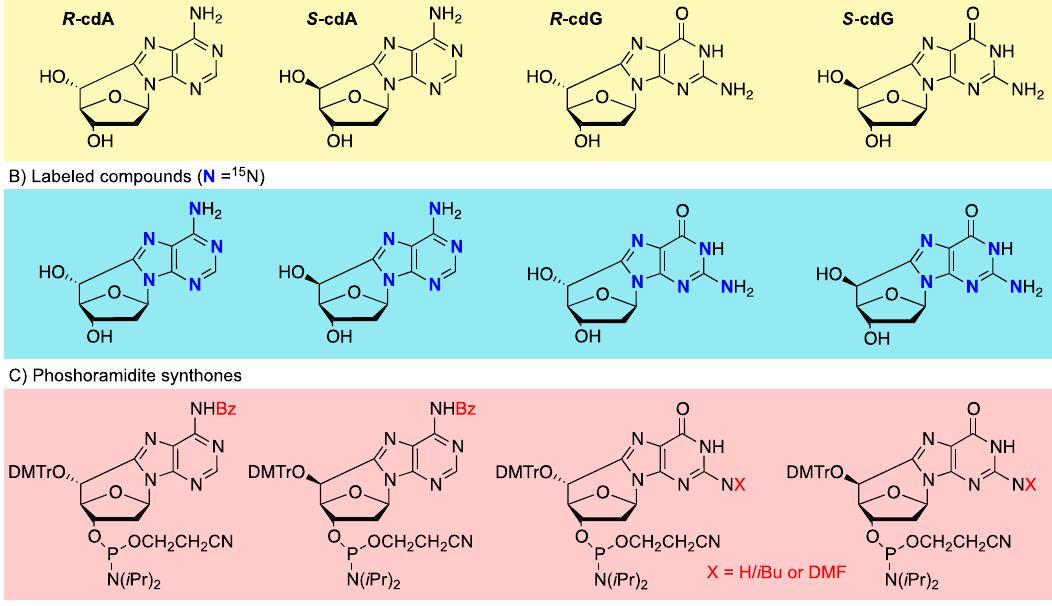
Figure 2. Libraries of purine 5 ′ ,8-cyclo-2 ′ -deoxynucleosides (cPu).